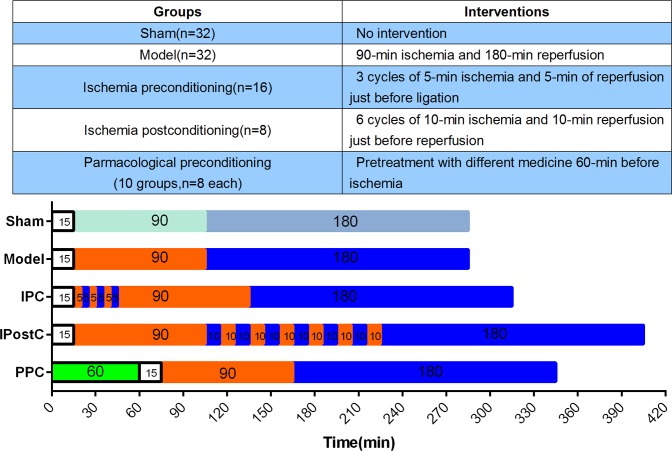
Animal Experiment protocol.Pharmacological preconditioning includes TXL, valsartan, nicorandil, rosuvastatin, simvastatin, carvedilol, tirofiban, diltiazem, verapamil and adenosine. Blood collection and measurement of functional parameters were done at before ligation, before reperfusion and before sacrifice. No-reflow and necrosis sizes were obtained after sacrifice. Abbreviations: IPostC = ischemia postconditioning; IPC = ischemia preconditioning; PPC = pharmacological preconditioning.